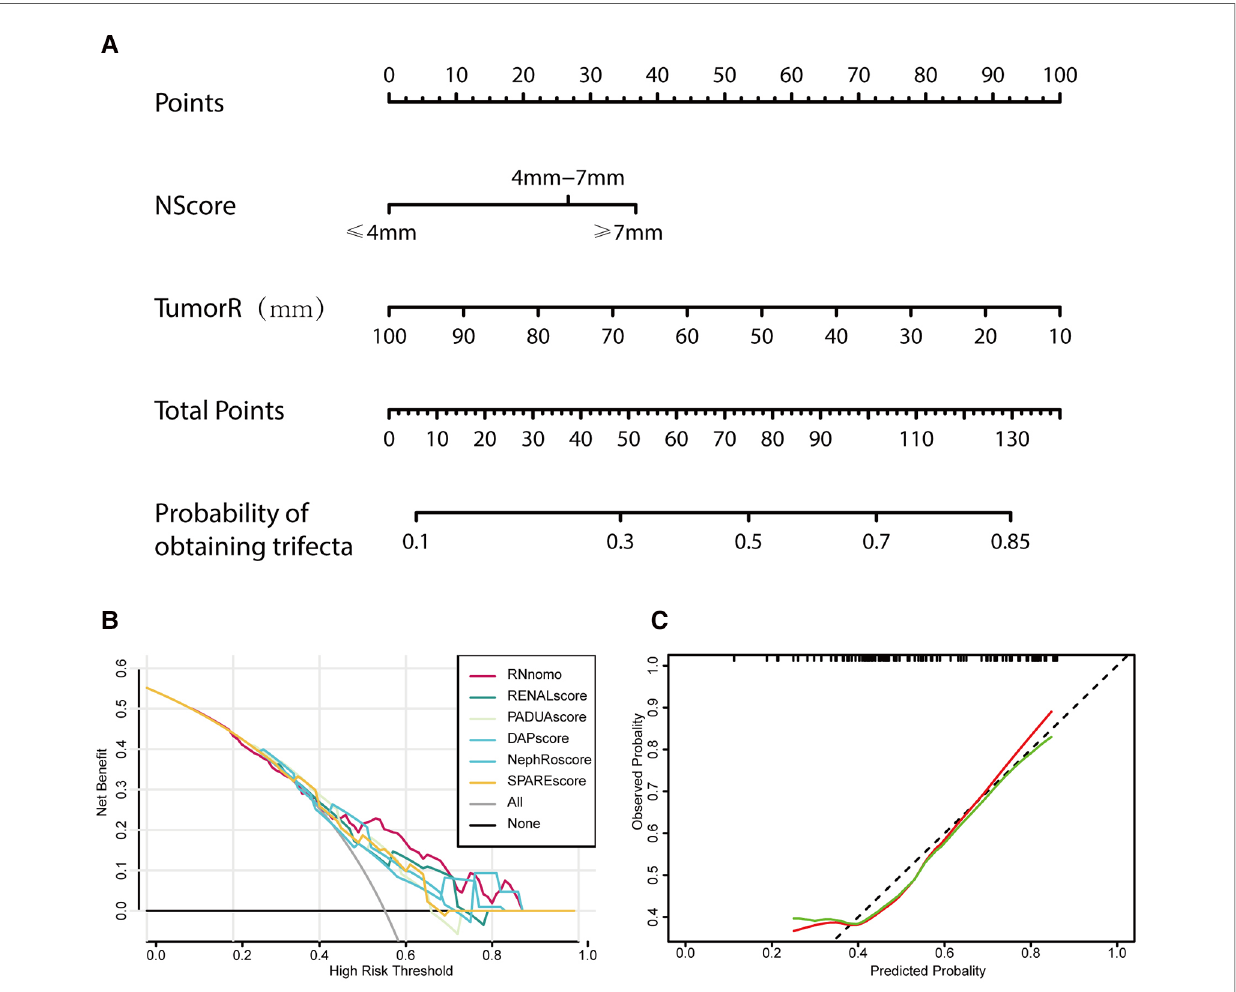
FIGURE 5 Tumor maximal diameter (NePhRO.R) and the distance between the tumor and the collecting system or renal sinus (RENAL.N) two elements are used to establish a nomogram ( A ), the decision curve is used to evaluate the predicted bene fi t by comparing the nomogram with the traditional scores ( B ), and the calibration curve is used to evaluate the deviation between the predicted value and the actual value of nomograms ( C